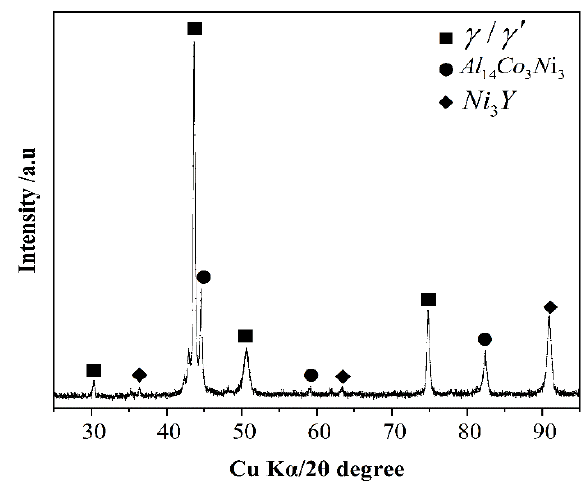
Figure 9. X-ray microdiffraction patterns of the alloys of the Y 2 O 3 systems. Table 2. Chemical compositions obtained via EDS analysis (at%).